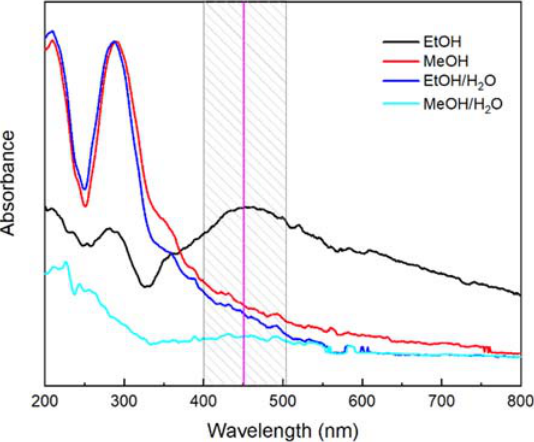
Figure 3. Ag NPs UV–Visible spectra from plant extract obtained by different types of solvents. The signals at wavelengths lower than 400 nm are attributed to traces of the extract that were not eliminated despite the purification and the washing steps to which the nanoparticles were subjected prior to their